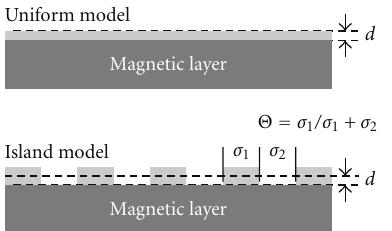
Figure 29: Lubricant coverage models. Θ is the lubricant coverage ratio in island model and d is the average thickness on magnetic layer.